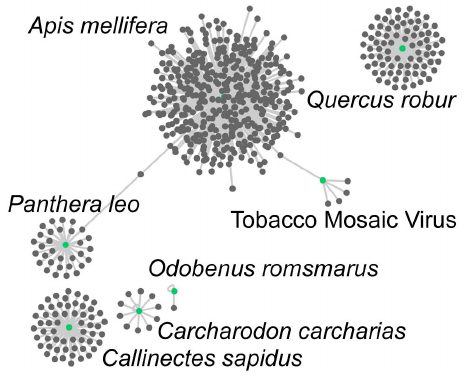
Figure 1. Automated Species Interactions. Taxon interaction network generated algorithmically by extracting information from text under the ‘‘Ecology’’ Chapter using the EOL and GNRD APIs. These associations are from the test species only.